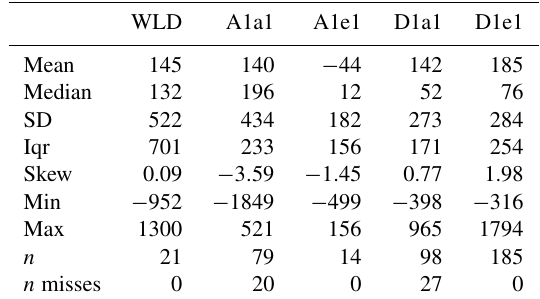
Figure 5. Comparison of bathymetry ( η ; panels a and b ) and di- vergence of flow direction ( ˇ D ; panels c and d ) for transects A–A’ (panels a , c ) and B–B’ (panels b , d ). (cid:49)l is the width of the gray box, or the location where ˇ D changes from positive to negative ( x ˇ red circle) minus the bathymetric maximum of the channel tip ( x ˆ η ; black circle). The distribution of (cid:49)l is shown in Fig. 6. Table 1. Statistics describing the distribution of (cid:49)l for the Wax Lake Delta (WLD) and four delta simulations. SD: standard devi- ation, Iqr: interquartile range, Min and Max: minimum and maxi- mum, n : number of measurements, n misses: the number of mea- surements for which (cid:49)l could not be